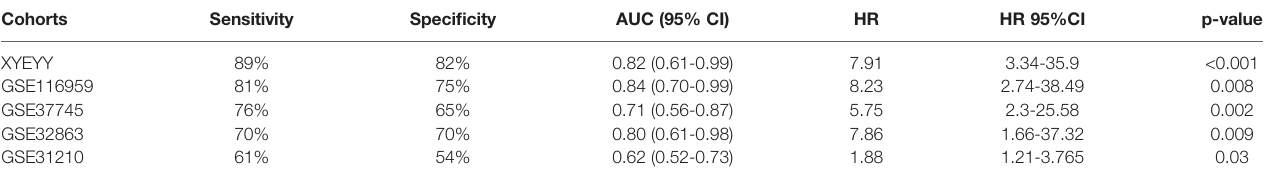
TABLE 3 | The combination of fi ve genes showed a strong association with tumor early recurrence in validation cohorts. Cohorts